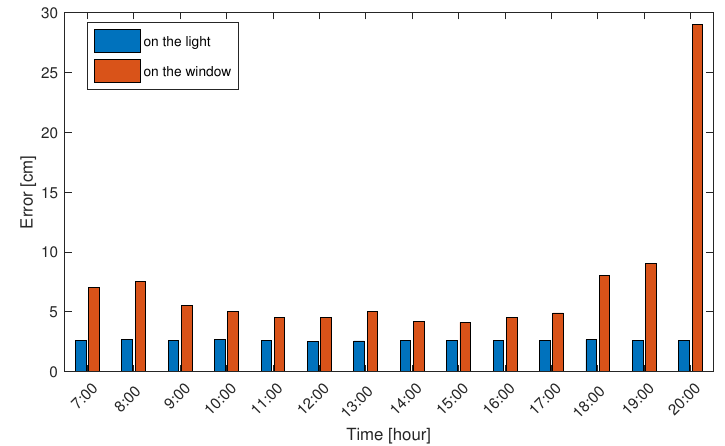
Figure 10. The influence of different time periods of a day on positioning